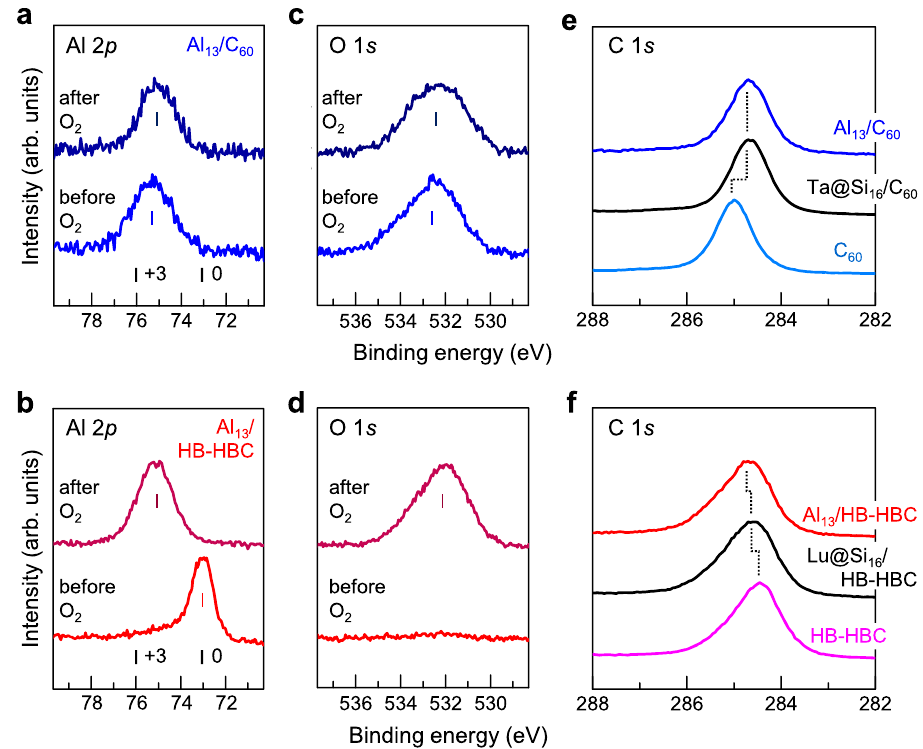
Fig. 1 XPS spectra for Al 13 on the C 60 and HB-HBC substrates. a – d XPS spectra around the Al 2 p core levels for a Al 13 on C 60 and b Al 13 on HB-HBC before (lower) and after (upper) O 2 exposure (at 5 × 10 10 Langmuir (L = 1.33 × 10 − 4 Pa·s)), along with c, d the O 1 s spectra for each state. e , f The XPS spectra around the C 1 s core level for the underlying e C 60 and f HB-HBC are also shown for the deposition of Al 13 and Ta@Si 16 or Lu@Si 16 . Reference binding energies (BEs) of Al 2 p 3/2 for the bulk Al (Al 0 and Al 3 + ) and O 1 s (O 2 − ) are marked by vertical bars. The BEs for Al 2 p show zerovalent Al 0 only for Al 13 on the HB-HBC substrate before O 2 exposure, while the other BEs are in the vicinity of Al 3 + . After the deposition of 0.6 ML Al 13 (blue) or Ta@Si 16 (black) on C 60 , the C 1 s peak in ( e ) shifts by ~0.3 eV toward a lower BE from that before deposition (light blue), indicating the presence of an anionic C 60 − state. After the deposition of 0.6 ML Al 13 (red) or Lu@Si 16 (black) on HB-HBC, the C 1 s peak in ( f ) shifts by ~0.25 eV toward a higher BE from that before deposition (pink), indicating the presence of a cationic HB-HBC +